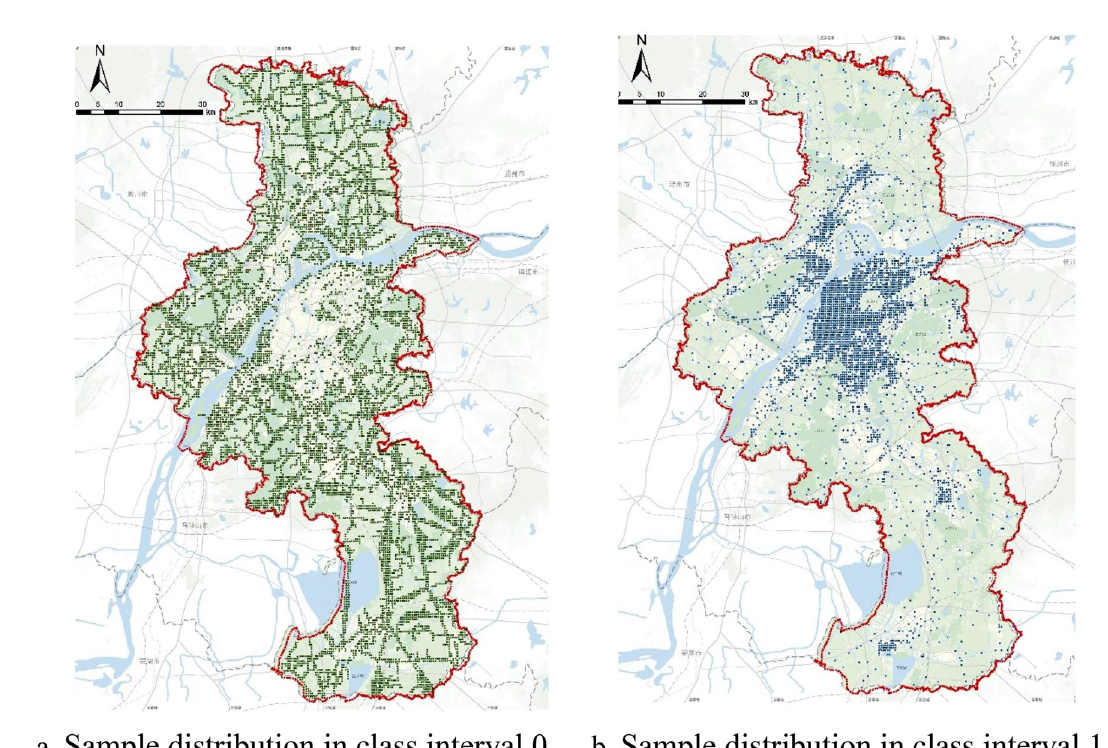
Figure 5. Sample distribution of classified training data set. Source Author made based on ESRI ArcGIS Pro Software (https:// pro. arcgis. com/ en/ pro- app/ latest/ get- start ed/ get- start ed.